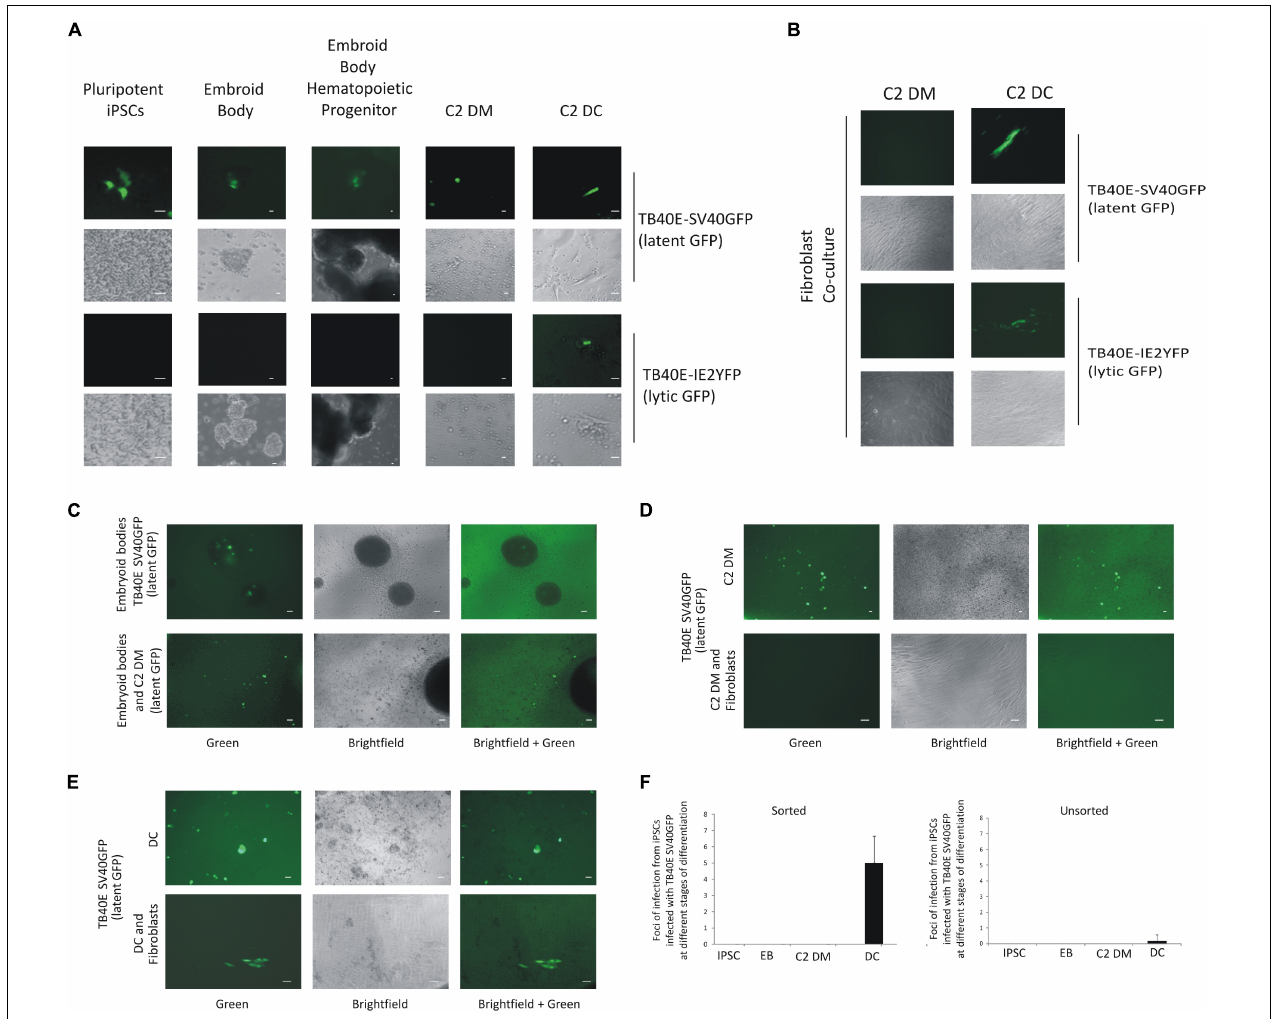
FIGURE 2 | C2 iPSCs infected with HCMV can support HCMV latency and reactivation and can be enriched by FACS sorting of GFP-positive cells. C2 iPSC cells were infected with HCMV viruses TB40E-SV40GFP (MOI 5) (latent GFP) or TB40E-IE2YFP (MOI 5) (lytic GFP) in C2 iPSCs for 4 days in which a latent infection was supported. Cells were then differentiated into embryoid bodies and through to C2 DMs which, after adherence, were further differentiated to C2 DCs, bar represents 5 µ m, fluorescence and brightfield images are shown (A) . C2 DMs and C2 DCs from these cultures were also assessed for their release of infectious virus by co-culture on indicator fibroblasts, bar represents 5 µ m, fluorescence and brightfield images are shown (B) . Alternatively, iPSCs infected with TB40E-SV40GFP (MOI 5) (latent GFP) were sorted for GFP and differentiated along the myeloid lineage to EBs and monocytes and assessed for GFP expression, bar represents 50 µ m (C) . To determine whether these cells were producing infectious virus, the monocytes (C2 DMs) were co-cultured with indicator fibroblasts directly (D) or after their further differentiation to DCs (E) , bar represents 50 µ m. Quantification of release of infectious virus for sorted latently infected C2 iPSCs and their derived EBs, C2 DMs, and C2 DCs are also shown where an average from 10 wells of a 6-well plate were counted and SD shown (F)